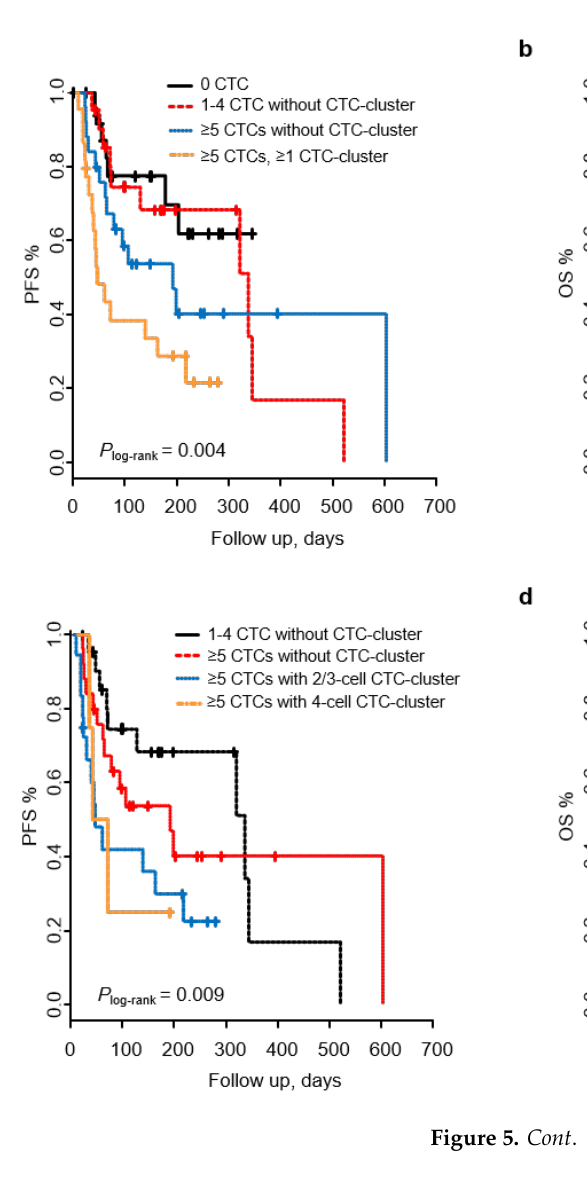
Figure 5. Longitudinal analysis for CTCs and CTC-clusters in relation to patient outcome. Kaplan– Meier curves displaying PFS and OS of patients without CTCs, patients with 1–4 CTC without CTC- clusters, patients with ≥5 CTCs without CTC-clusters and patients ≥5 CTCs with CTC-clusters ( a, b ). The predictive value of CTC-cluster size was also analyzed. Kaplan–Meier curves displaying PFS and OS of patients with 1–4 CTC without CTC-clusters, patients with ≥5 CTCs without CTC-clusters,